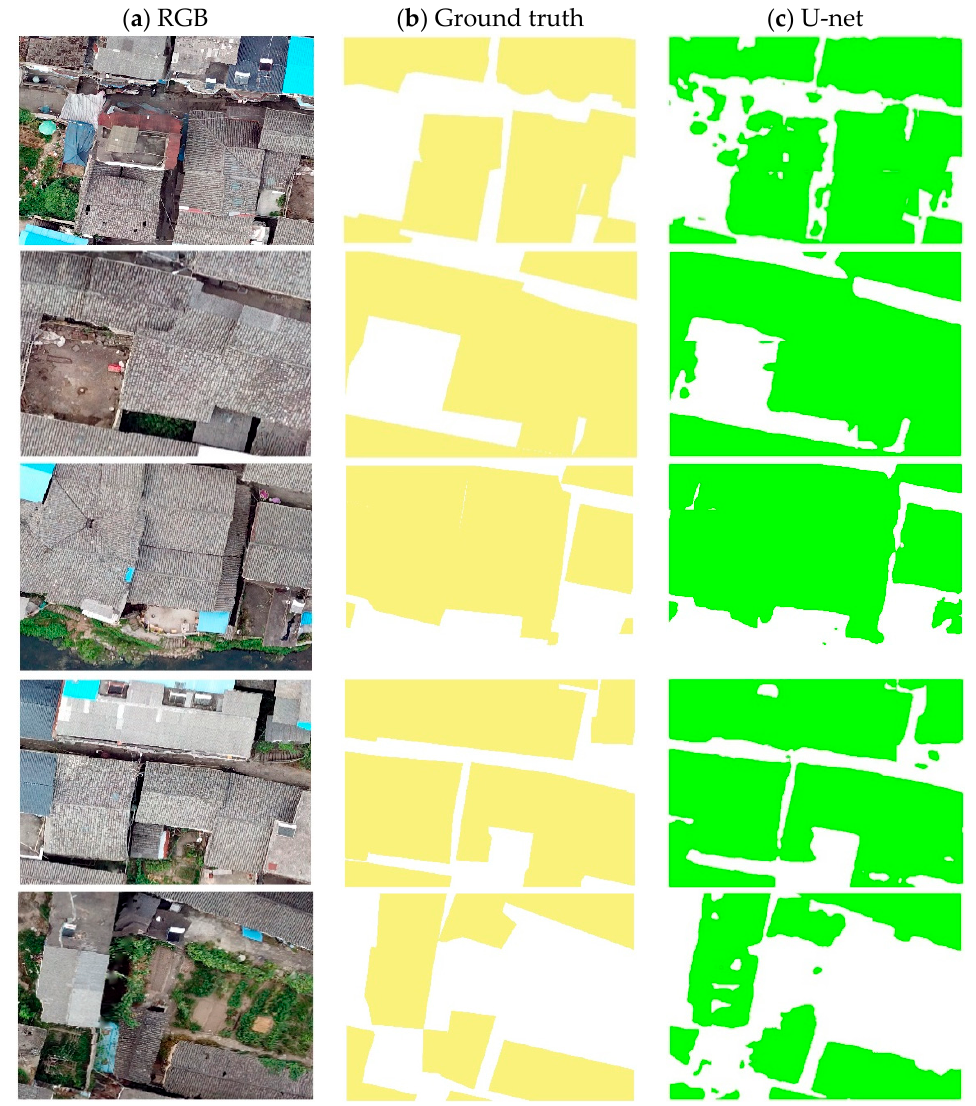
Figure 3. Comparison of the unmanned aerial vehicle (UAV) image, ground truth, and U-net algorithm recognition results in indicative regions. ( a ) UAV red, green, and blue wavelength (RGB) images, ( b ) corresponding ground truth images (yellow for homesteads and white for other areas), and ( c ) results identified by the U-net algorithm (green for homestead and white for other areas). Table 1. Validation of the U-net algorithm identification results.